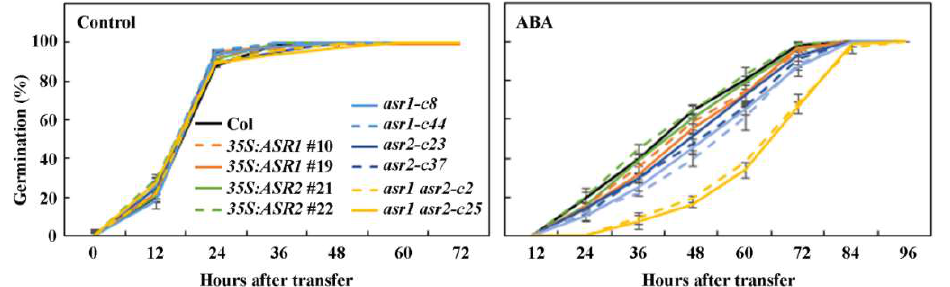
Figure 4. Effects of ABA on seed germination of the Col wild type, the 35S : ASR1 and 35S : ASR2 transgenic plants, the asr1 and asr2 single and the asr1 asr2 double mutants. Sterilized seeds were sown on 1/2 MS plates with or without 0.5 μM ABA. The plates were kept at 4 °C in dark for 2 days and then transferred to a growth room. Germinated seeds were counted every 12 h after the transfer until all the seeds were germinated, and percentage of germination was calculated. Data represent the mean ± SD of three repeats.